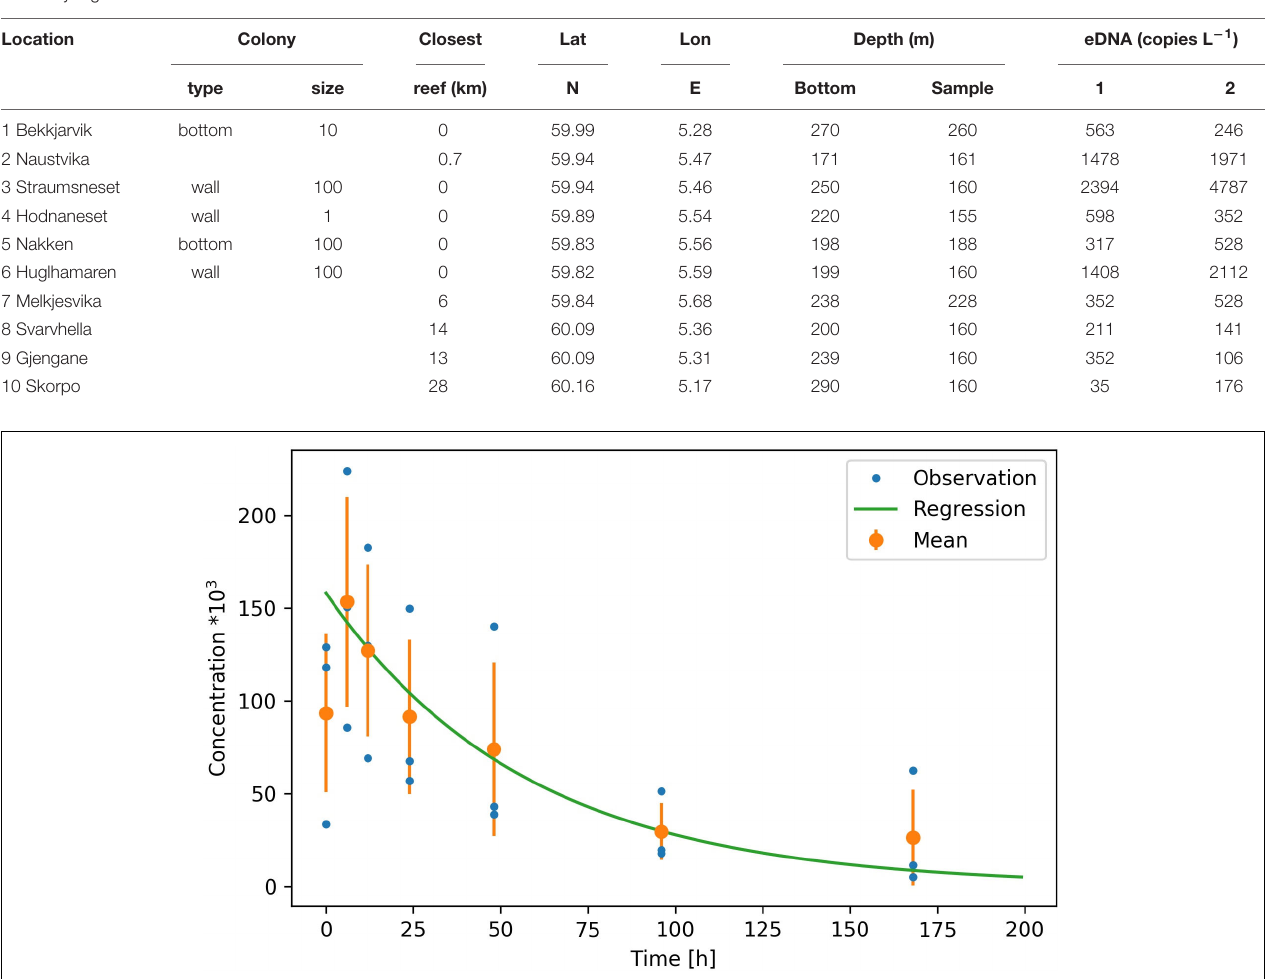
FIGURE 2 | Decay rate for the Lophelia pertusa targeted eDNA fragment measured in microcosm experiments at ambient temperature (8 ◦ C) and salinity (33 ) over 168 h. Three replicate observations (attained by placing one coral colony into each of three separate microcosms) are given by blue dots, the mean and standard deviation of the observations are given by the orange dots and error bars and the exponential regression is given by the green line (excluding the initial 5 h of